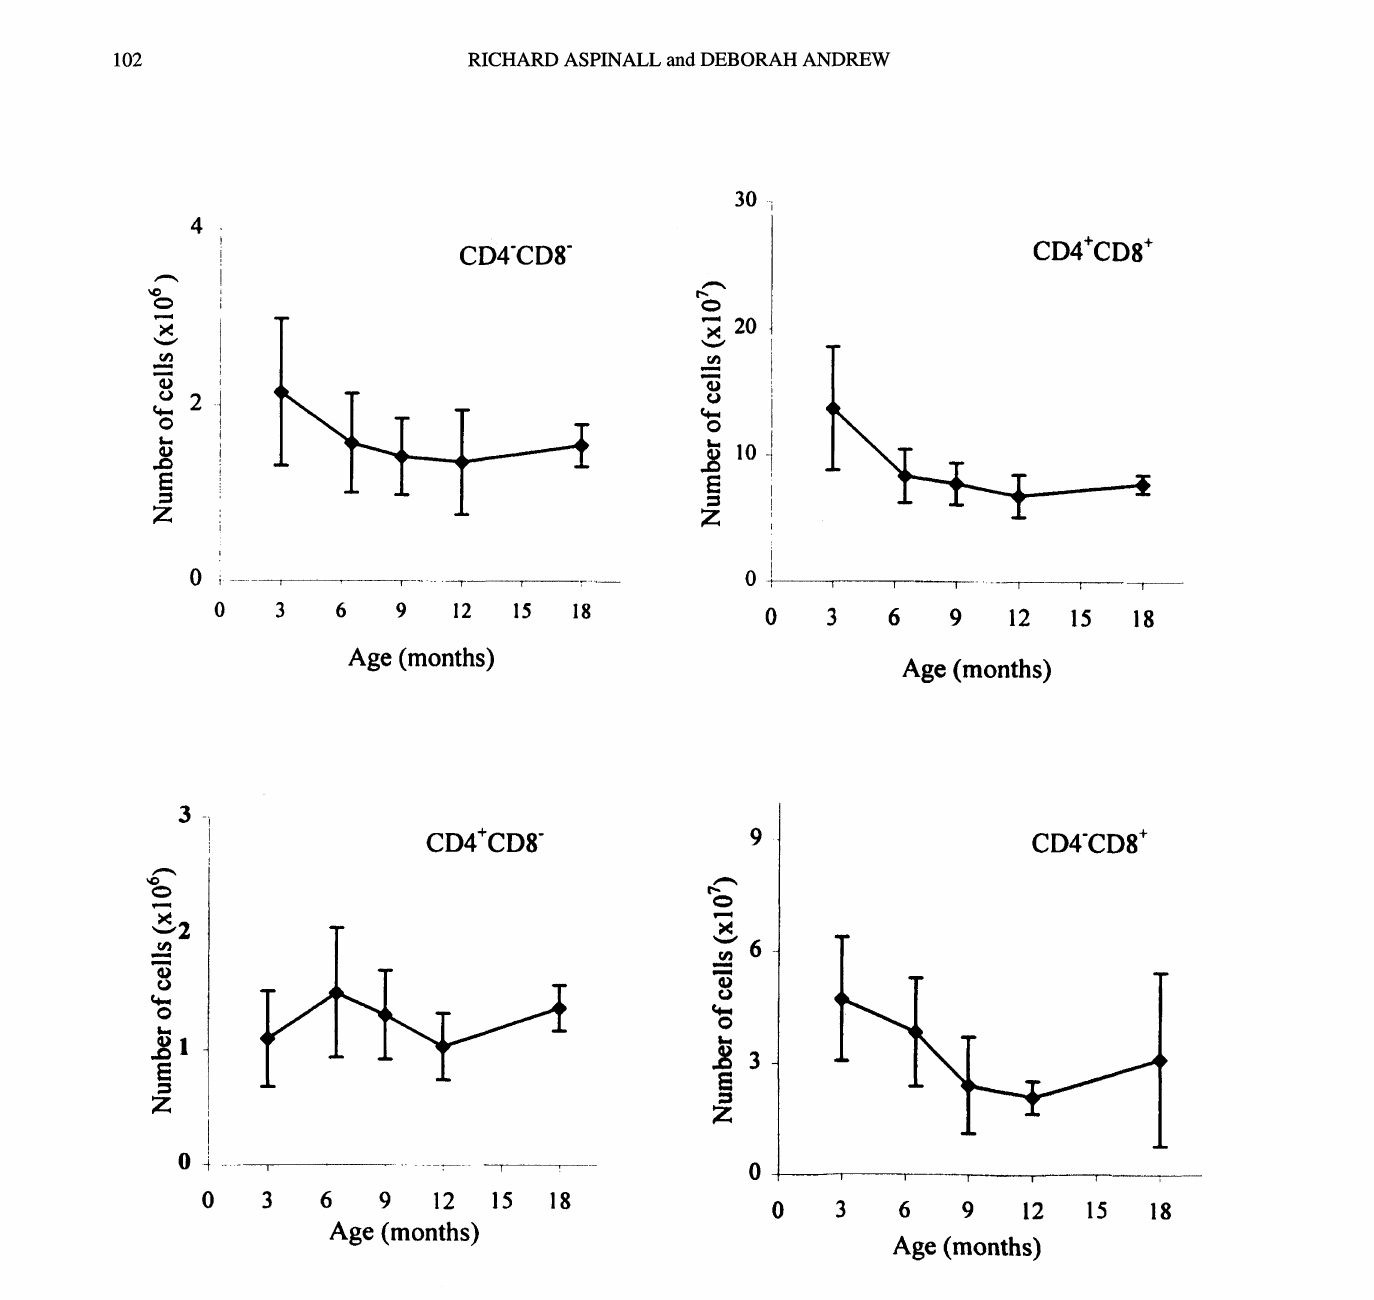
FIGURE 4 Age associated thymic atrophy was not observed in female F5 transgenic mice. Comparison ofthe numbers within the population defined by their expression of CD4 and CD8 in female mice reveals no difference with age (n=3-6 animals at each time